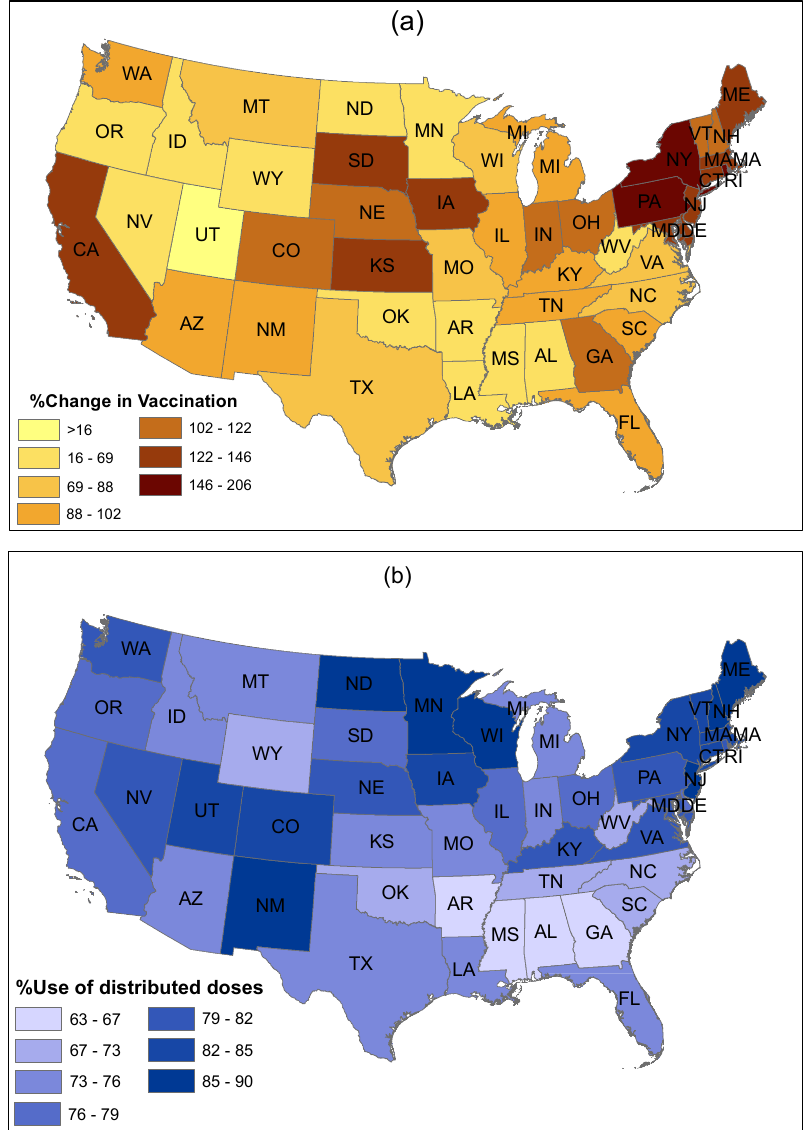
Figure 14. ( a ) Relative changes in vaccination between February (average vaccination from 3 to 10 February) and March (March 25 to April 1), 2021, ( b ) Percentage use of distributed vaccines, as of April 28 (Data source: